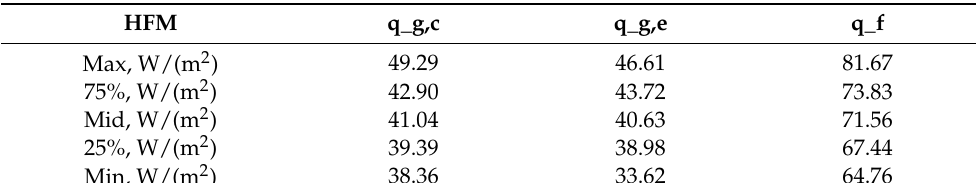
Table 5. Window U-value using the HFM method.